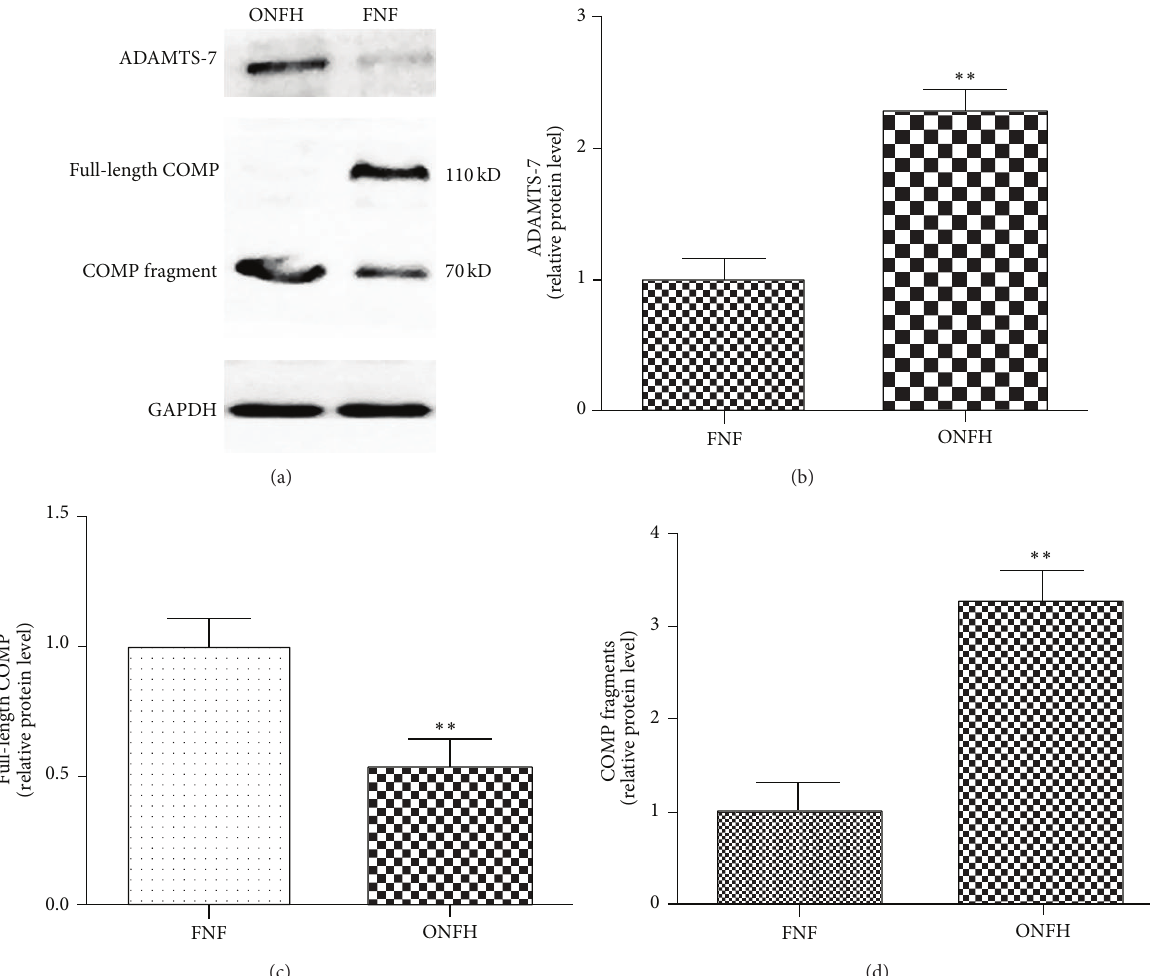
Figure 4: ADAMTS-7 associates with and degrades COMP in ONFH patients. (a) Representative western blotting of cartilage from ONFH and FNF patients. ADAMTS-7 (180kDa), full-length COMP (110kDa), and COMP fragment ( ≈ 65kDa) were detected by western blot analysis. Expression levels of each gene are expressed as percentage of control. Expression level of ADAMTS-7 (b) and COMP fragment (d) is significantly increased in ONFH patients compared to in FNF patients, while the full-length COMP (c) level was decreased in ONFH patients ( ∗ 𝑃 < 0.05 , ∗∗ 𝑃 < 0.01